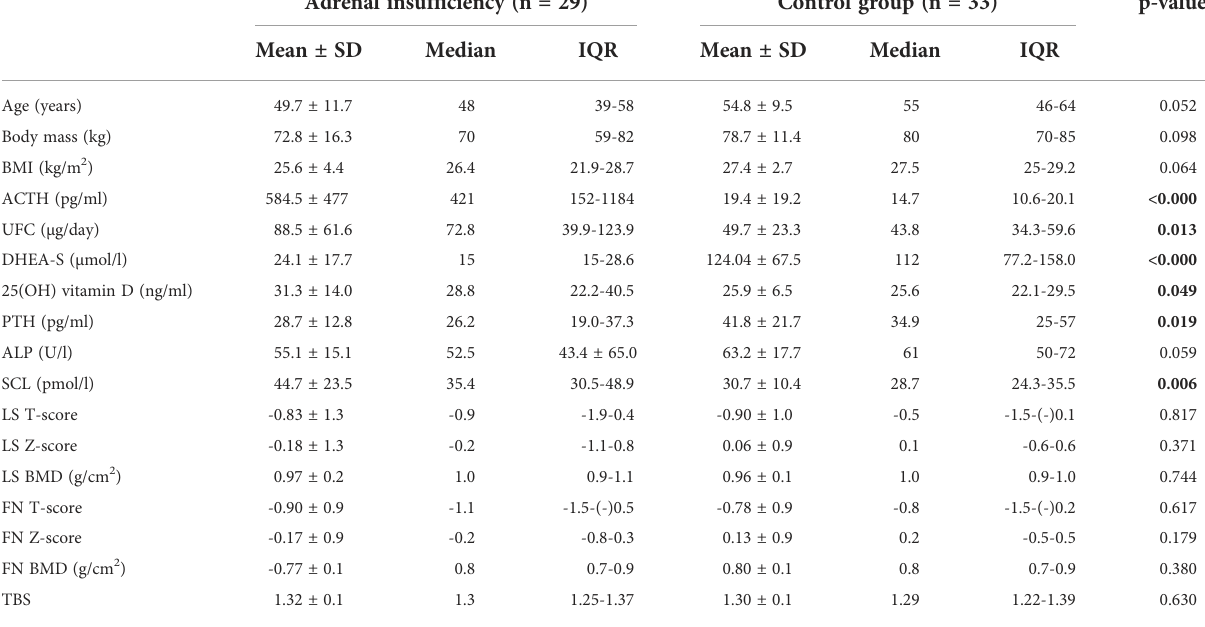
TABLE 1 Characteristics of the patients with primary adrenal insuf fi ciency and